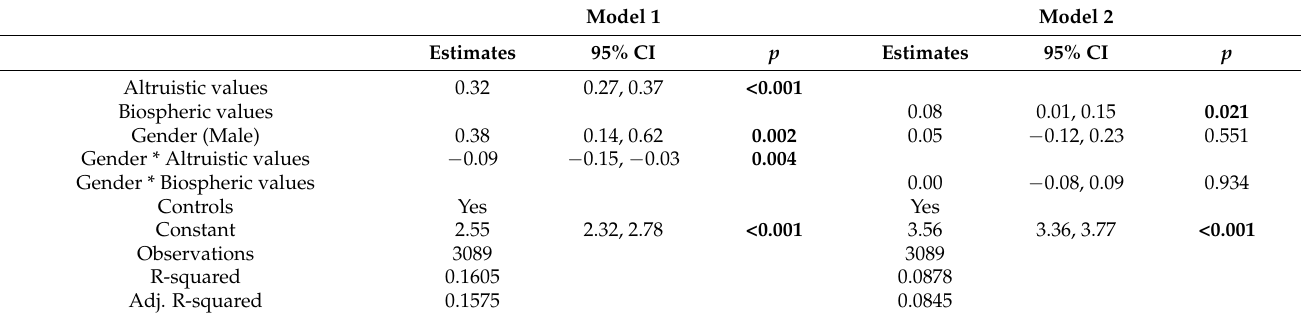
Table 10. Moderating effect of gender in the relationship of altruistic values and